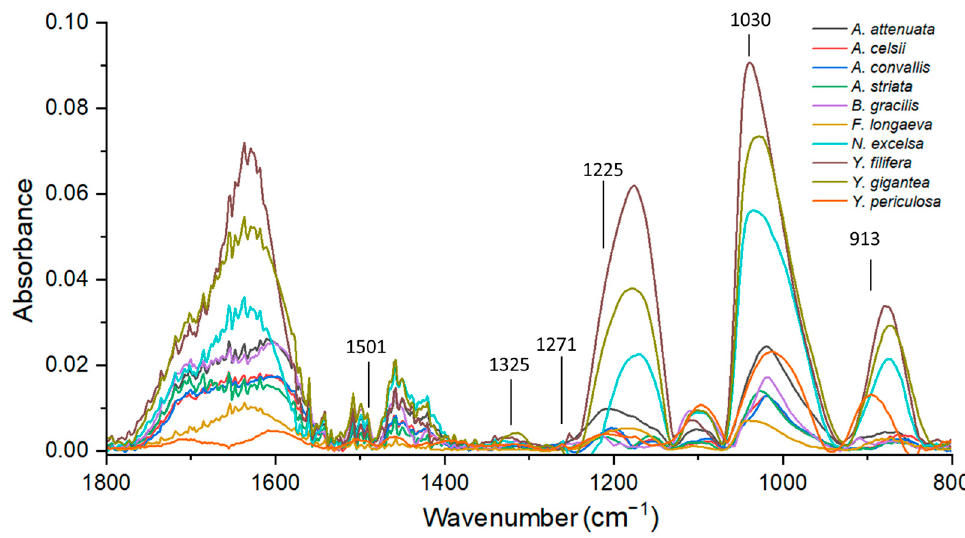
Figure 3. FTIR spectra of the lignin fingerprint of the Asparagaceae species. Whit the peaks 1325 and 1271 cm − 1 the S/G ratio was calculated (Table 8). The species with the lowest proportion of S/G was A. attenuata because it had a higher percentage of guaiacyl in its structure, while in the genus Yucca , the three species presented high values of syringyl, for which the proportion of S/G was in the range of 2.8 to 3.9. The other species had similar proportions, so the syringyl monomer prevailed except in A. convallis . Table 8. Percentages of syringyl and guaiacyl, and S/G ratio of Asparagaceae species. Species Guaiacyl (%) Syringyl (%) S/G Ratio Agave attenuata 63.1